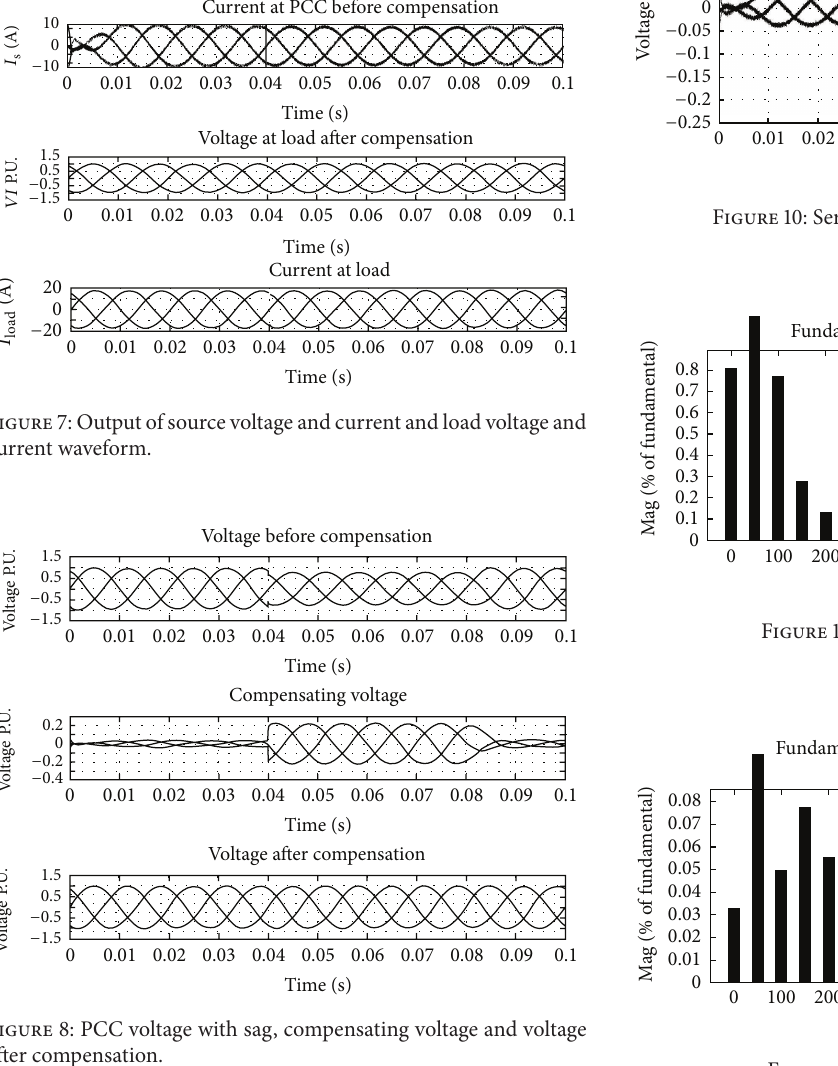
Figure 12: Load voltage THD graph.